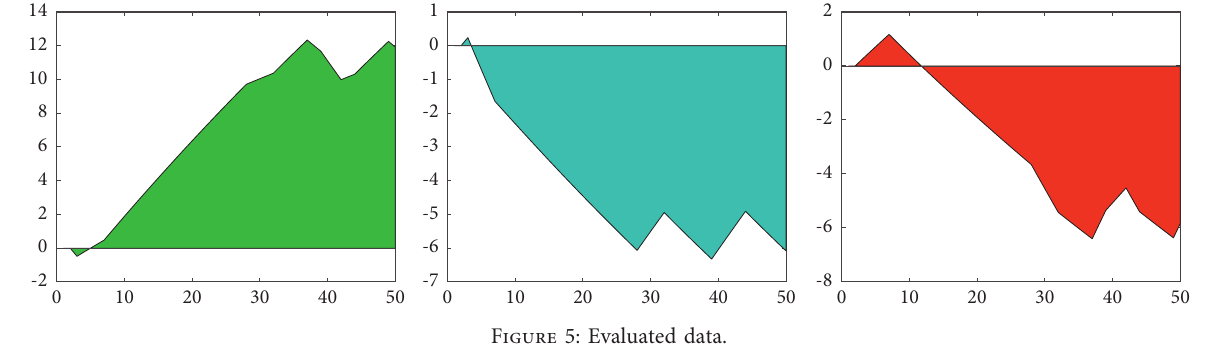
Figure 5: Evaluated data.